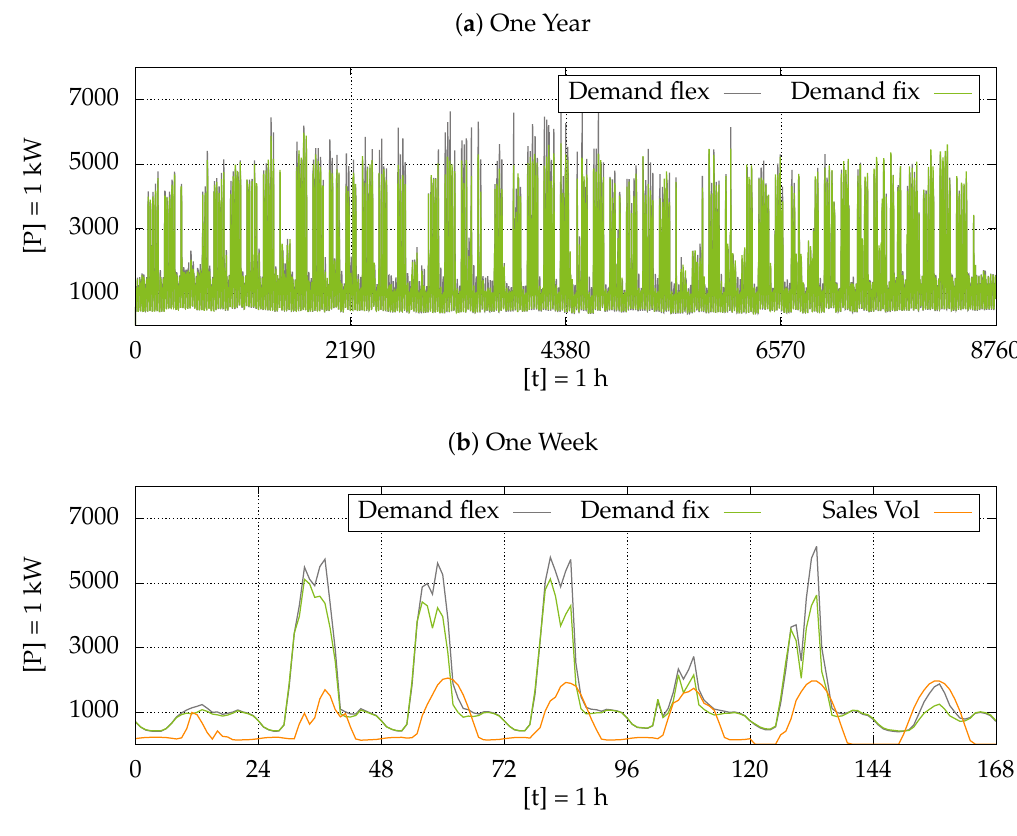
Figure 10. Green electricity demand in fix and flex price scenario over ( a ) one year ( 1 January 2015–31 December 2015 ) and ( b ) one week ( 18–24 May 2015